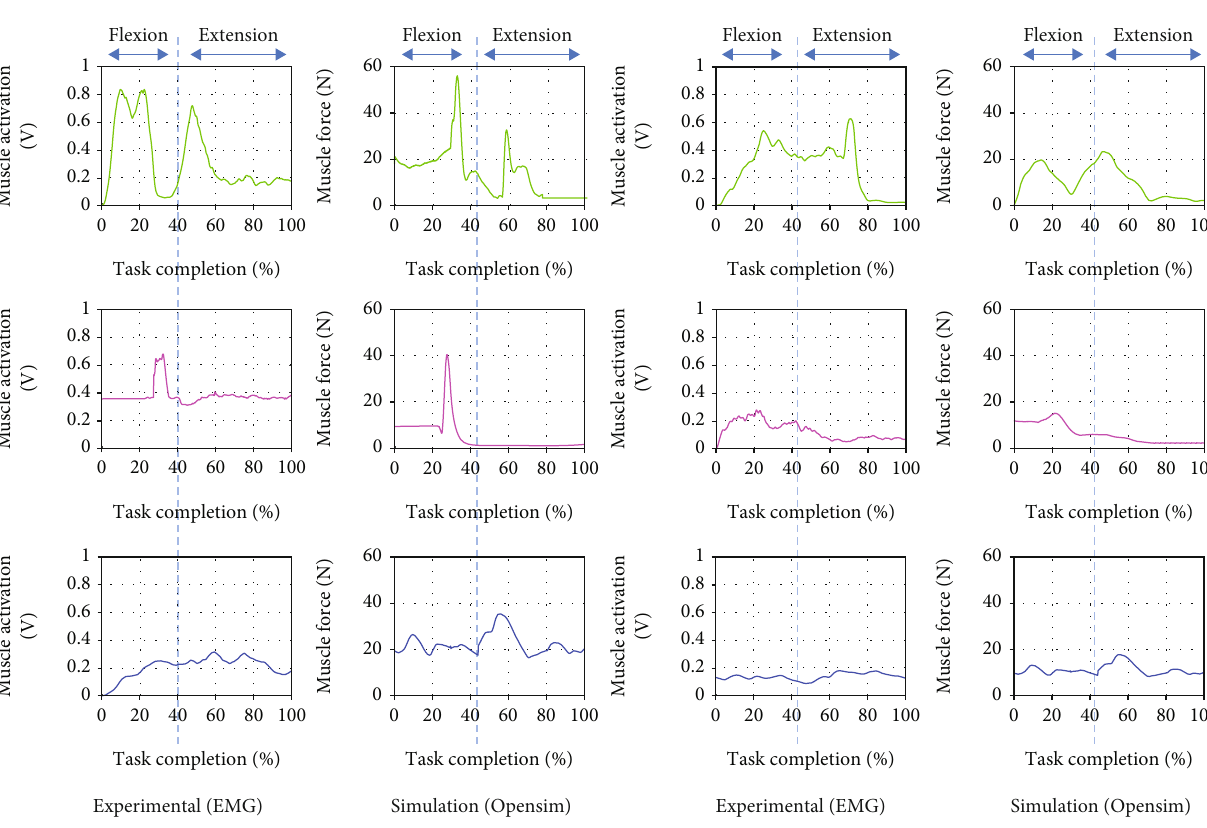
Figure 10: Comparison of EMG from experimental and muscle activations computed from OpenSim resulting in three muscle force brachioradialis (green), biceps (magenta), and triceps (blue) for 90-degree elbow fl exion and extension motion with and without the assistive